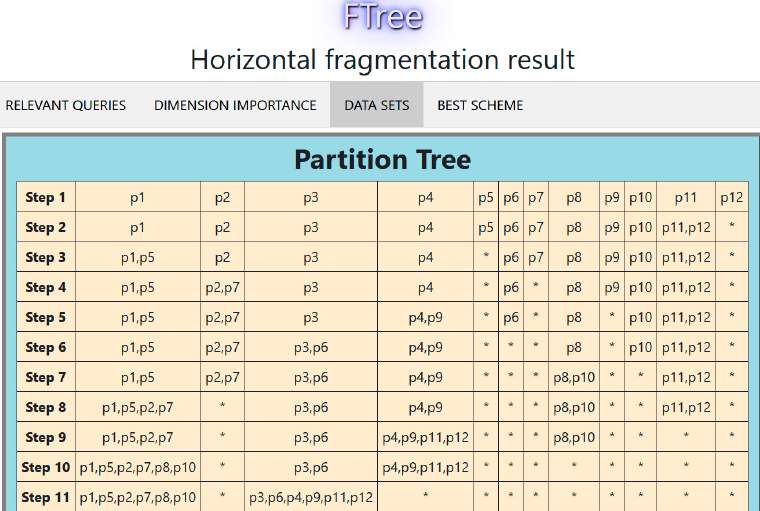
Figure 10. Comparison of fragmentation schemes with 2 and 3 fragments. Figure 11. Decision tree for 2 fragments found by FTree for the second experiment.